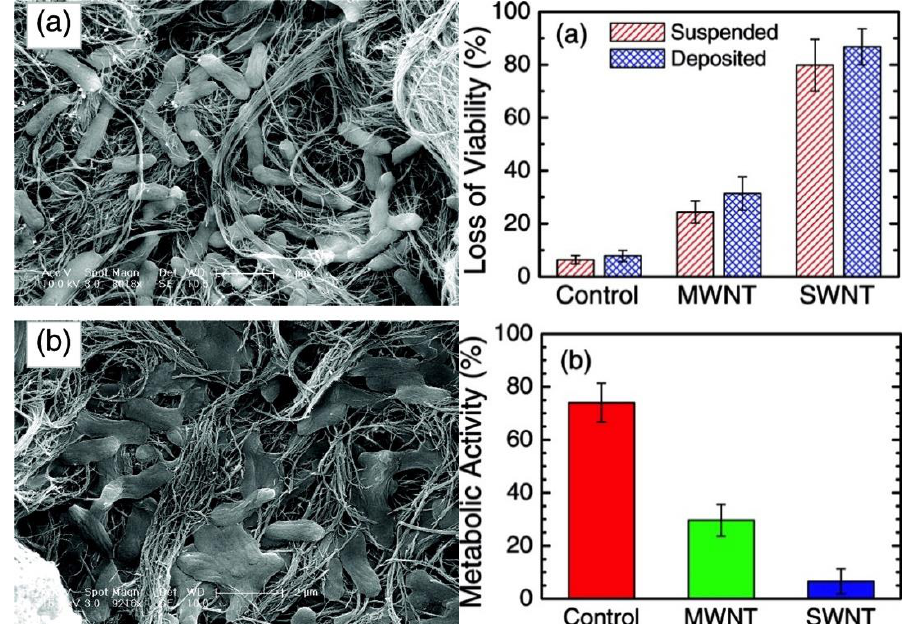
Figure 3. Left: Scanning electron microscopy (SEM) images of E. coli cells exposed to CNTs: ( a ) cells incubated with MWNTs for 60 min; and ( b ) cells incubated with SWNTs for 60 min. The bars in both images represent 2 µm. Right: Bacterial cytotoxicity of carbon nanotubes: ( a ) fluorescence-based toxicity assay of SWNTs and MWNTs for suspended- and deposited-type experiments with E. coli ; and ( b ) metabolic activity test of E. coli cells deposited on a CNT-coated filter and a control PVDF membrane. Obtained from [20], with permission from the American Chemical Society 2008.